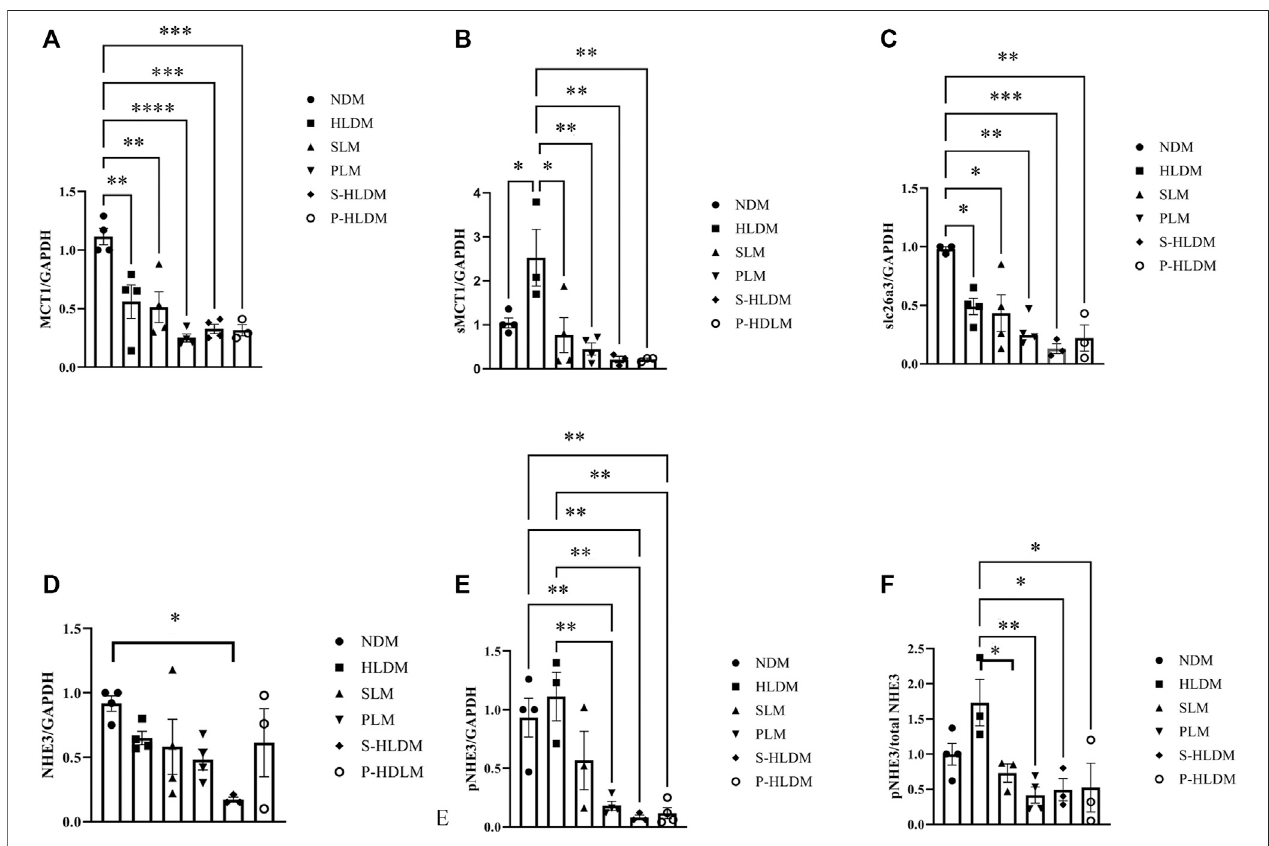
FIGURE7| Theexpression levelsofion transporters wereanalyzedbyWestern blot, and thedensity ofMCT (A) ,sMCT1 (B) ,SLC26A3 (C) ,NHE3 (D) ,pNHE3 (E) and pNHE3/NHE3 (F) was calculated as shown in different groups. Data are represented as the mean ± SEM (n = 3). * p ≤ 0.05, ** p ≤ 0.01, *** p ≤ 0.001.